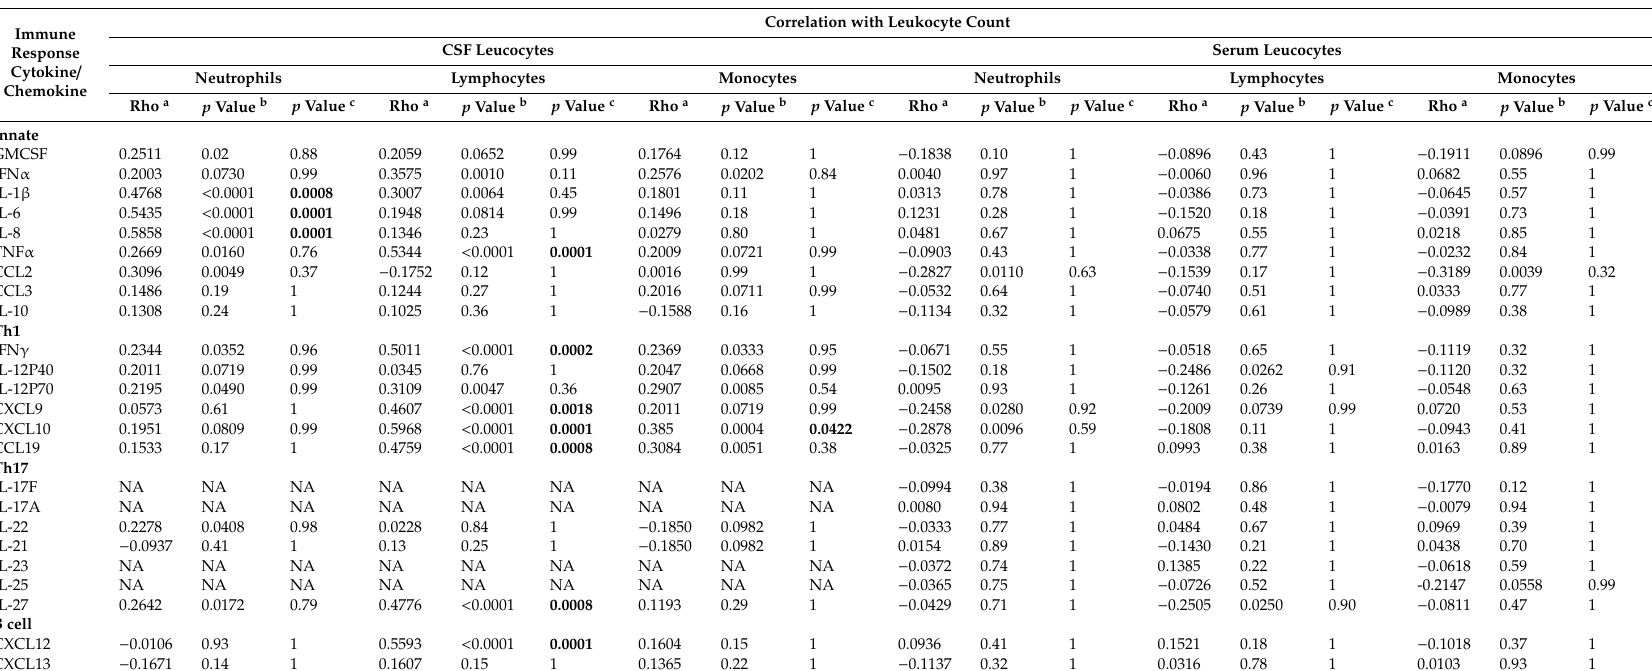
Table 3. Correlation of Cytokine and Chemokine Levels in Blood or Cerebrospinal Fluid (CSF) and White Cell Counts in Blood or CSF (Determined in the Meningoencephalic Phase of Tick-borne